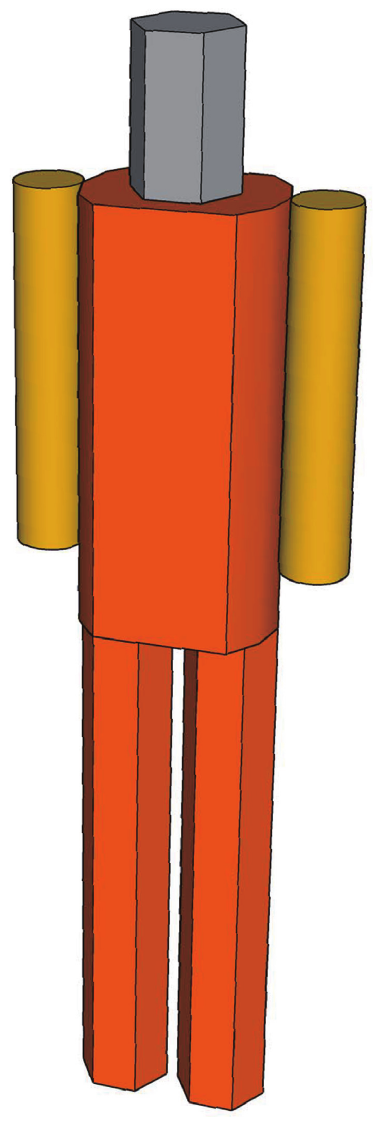
Figure 17: The reference human body